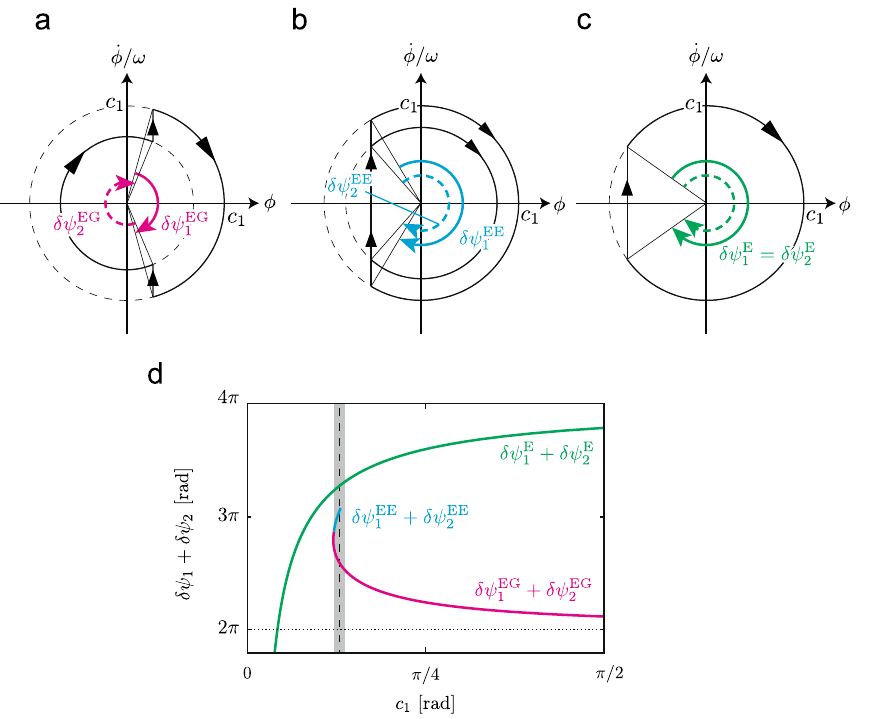
1, 2 ) of phase angle of spine joint angle φ , for solutions of ( a ) type EG, ( b ) type Figure 7. Changes δψ i ( i = δψ 2 for amplitude c 1 of spine joint angle φ for periodic solutions. Dashed line is EE, and ( c ) type E. ( d ) δψ 1 + average measured c 1 values in cheetahs, and gray area shows standard